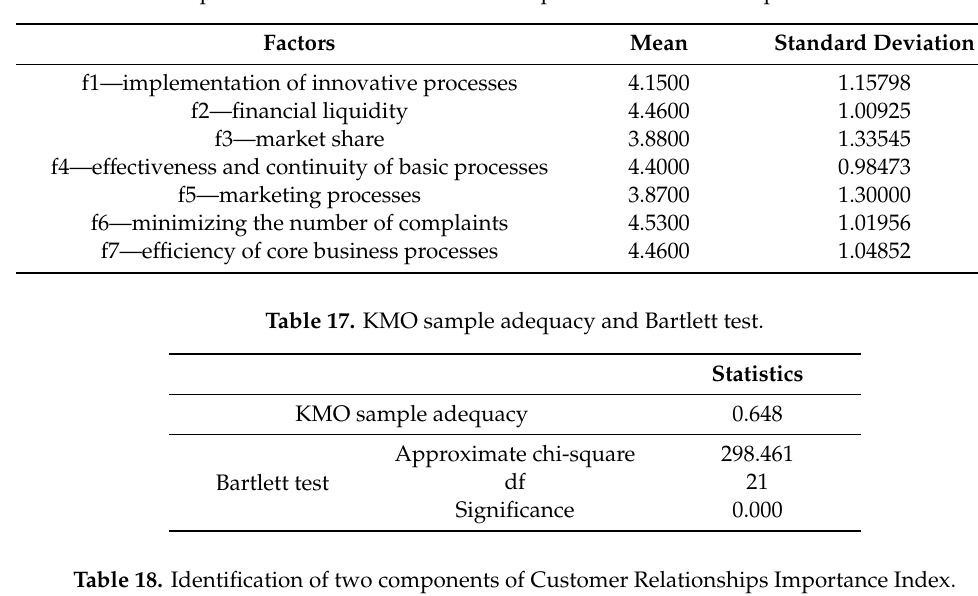
Table 16. Descriptive statistics for factors of the importance of relationships with Customers 4.0.